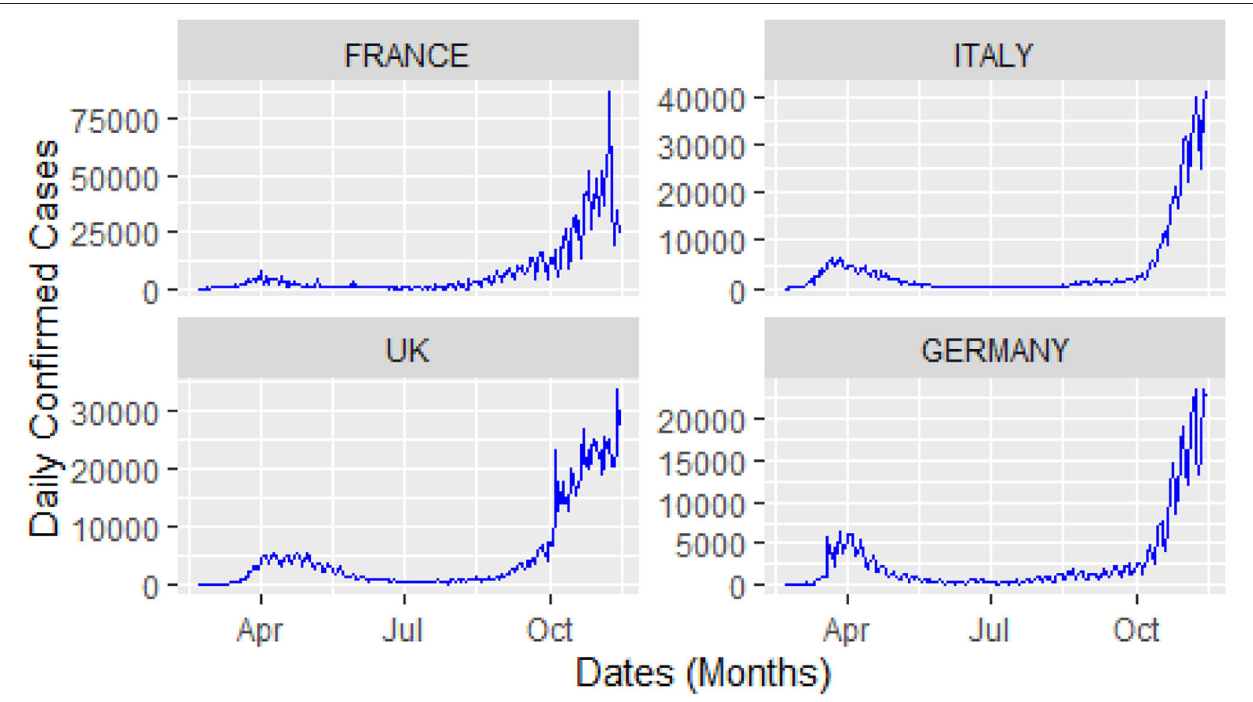
FIGURE 3 | Daily confirmed cases: time window from 23 February 2020 to 14 November 2020.